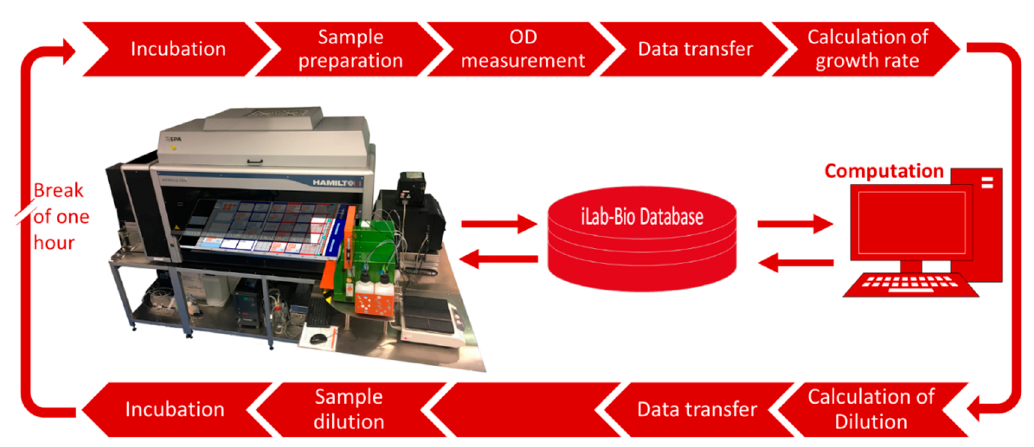
Figure 5. Robotic platform and workflow used for the quasi-turbidostat cultivation for the preparation of competent cells. The incubator is mounted on the left site of the liquid handling station, the plate reader is mounted on the right site. During the quasi-turbidostat cycle, the cells are transferred from the incubator to the liquid handler, a sample is taken, diluted, and measured in the plate reader. Afterwards, the OD 600 values are transferred into the database and the execution of the script is triggered. The script calculates the current dilution of the quasi-turbidostat cultivations and sends the set points back to the database. Subsequently, the liquid handler reads the set points for the database and executes the dilution step. The cells are incubated for one hour until the next cycle is started.